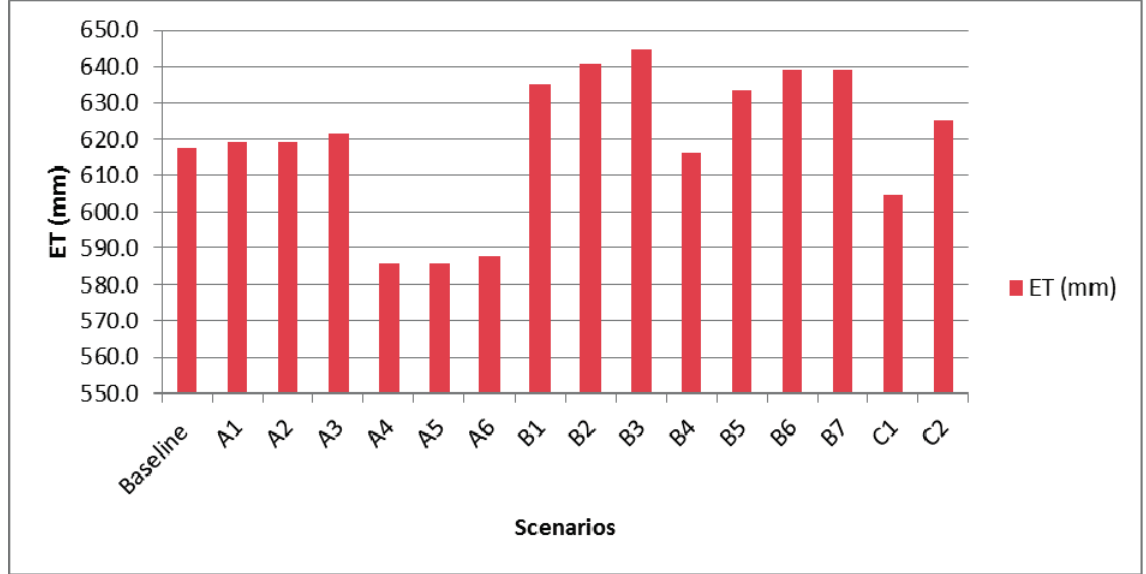
Figure 5. Annual Average Water Yield at the watershed scale under the 15 different scenarios.